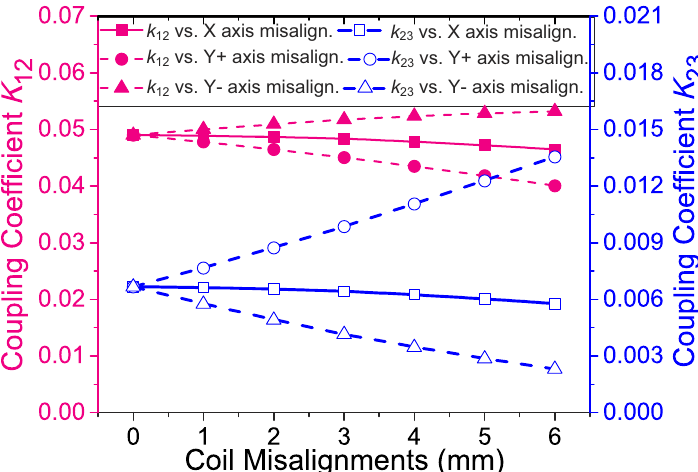
Figure 9. Calculated coupling coefficient k 12 and k 23 versus three different misalignments of the implant coil (‘Y+’ in the notation means misalignments in the positive direction of the Y axis, and ‘Y − ’ means in the negative direction. The directions of the X axis and the Y axis are illustrated in Figure